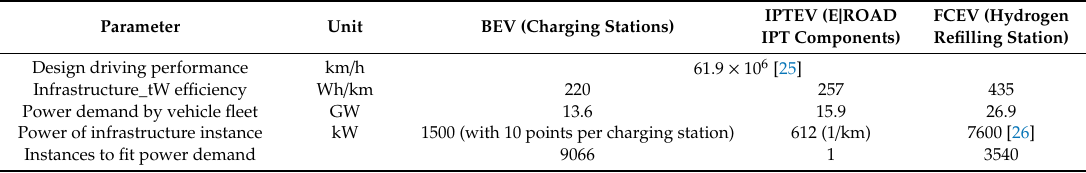
Table 2. Tra ffi c performance-dependent infrastructure